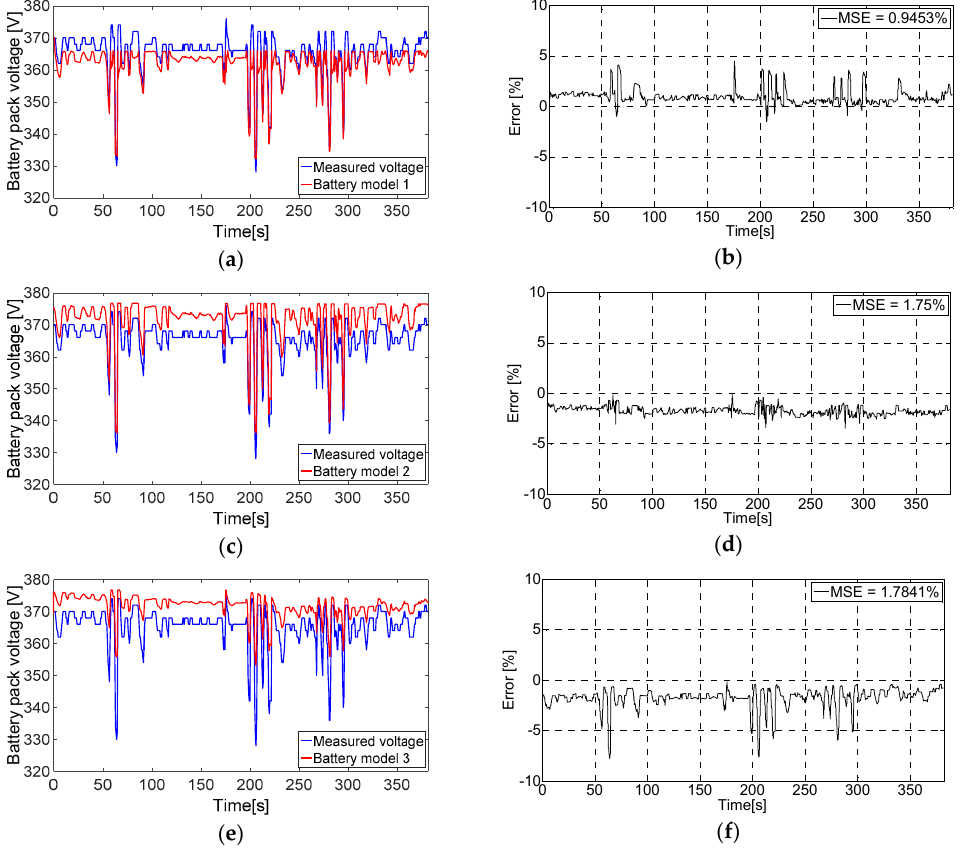
Figure 9. Battery simulation models and reference voltage signal for circular driving test: ( a ) Battery model 1 response; ( b ) Mean square error of battery model 1; ( c ) Battery model 2 response; ( d ) Mean square error of battery model 2; ( e ) Battery model 3 response ( f ) Mean square error in battery model 3.